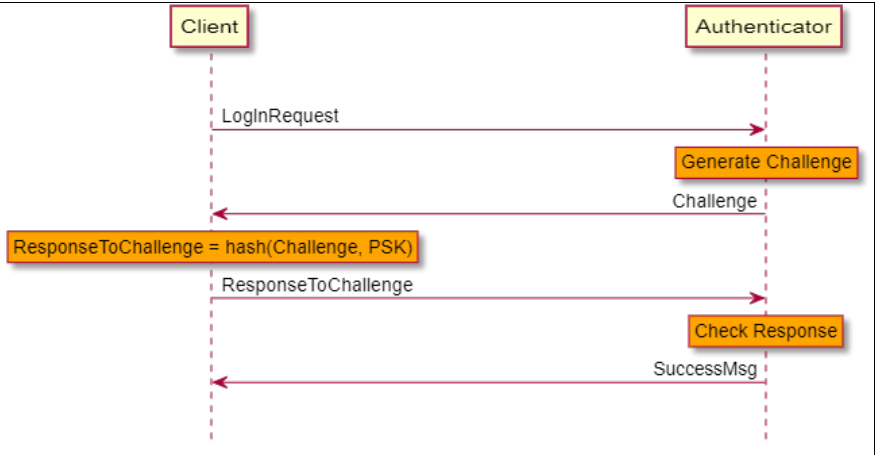
Figure 2. Legacy Challenge–Response authentication